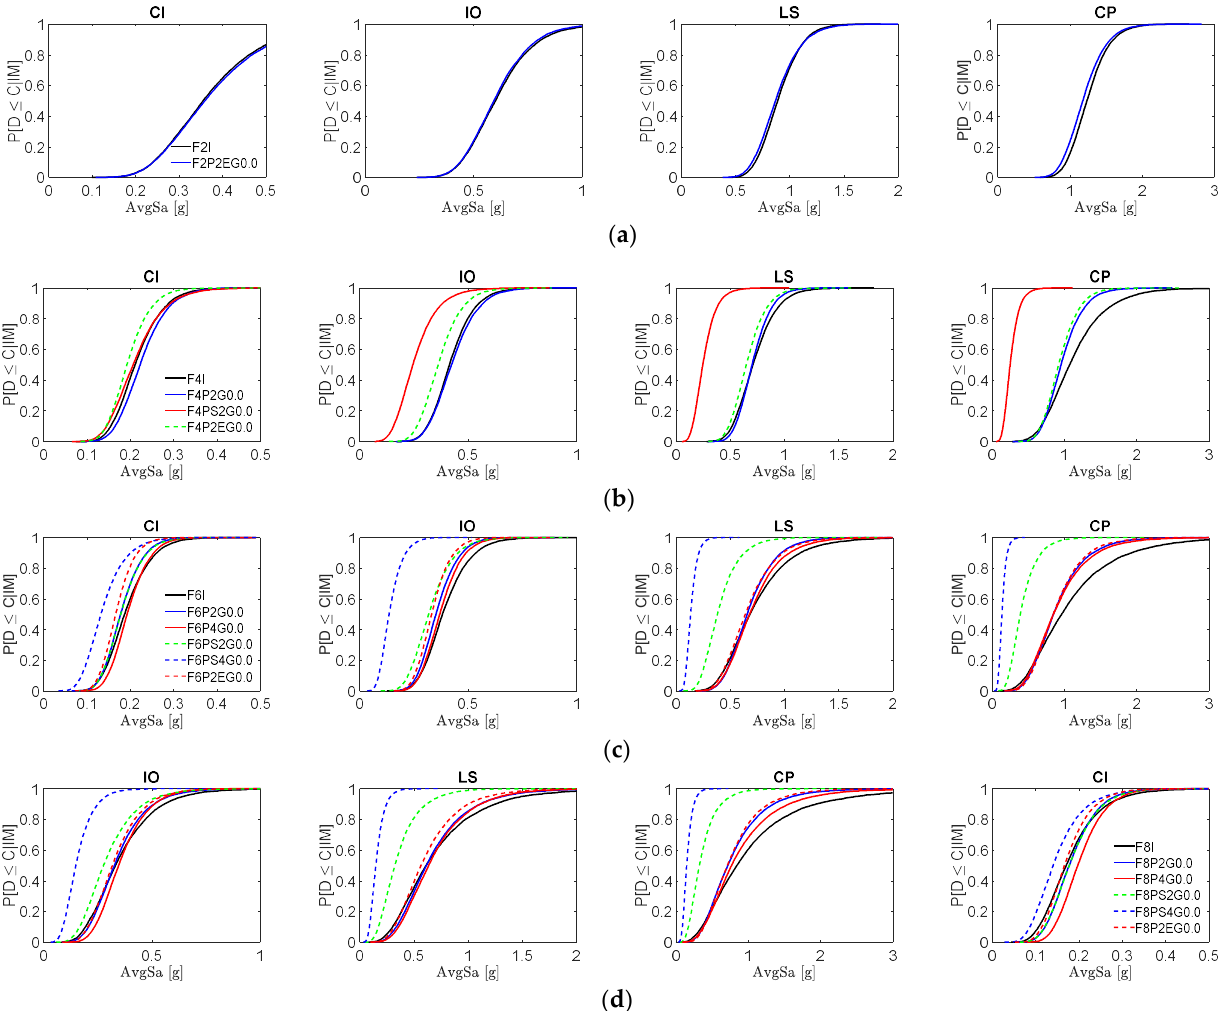
Figure 20. Fragility functions obtained for the different pounding configurations without using a seismic separation distance: cases where the left-hand side structure is a 2-storey structure ( a ), a 4-storey structure ( b ), a 6-storey structure ( c ) and an 8-storey structure ( d ).